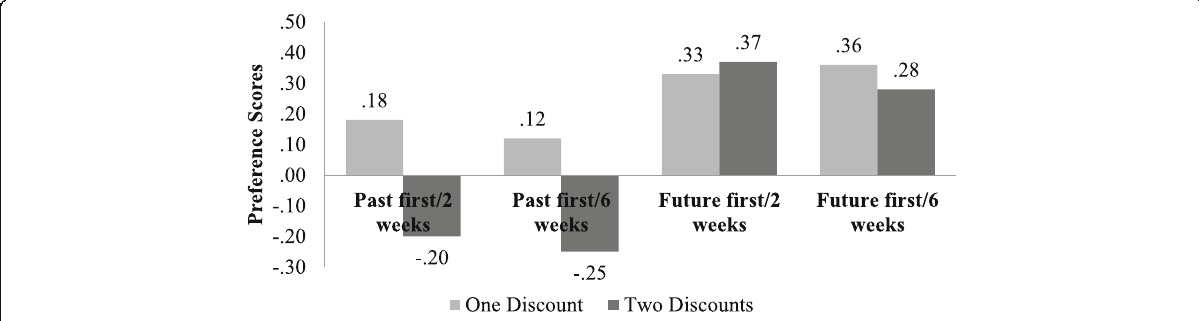
Fig. 3 Mean preference scores for the scenarios with one discount and two discounts in all four conditions